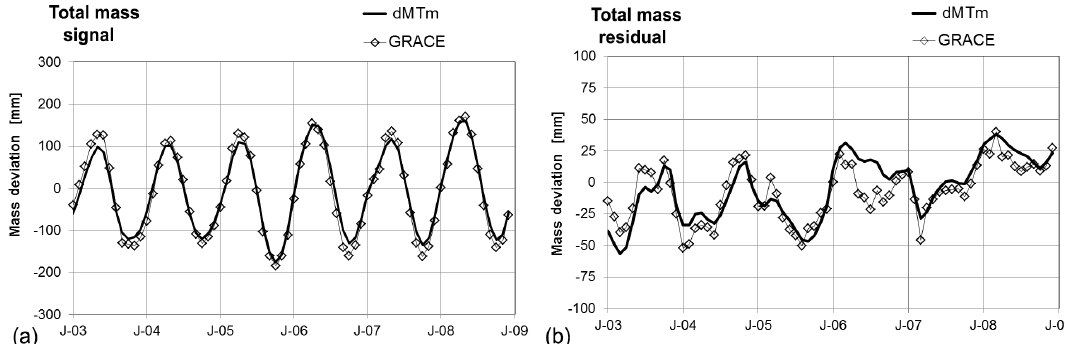
Figure 9. Time series of total mass anomalies d M T for the Amazon and optimization versus GRACE for the signal (a) for the residual (b)